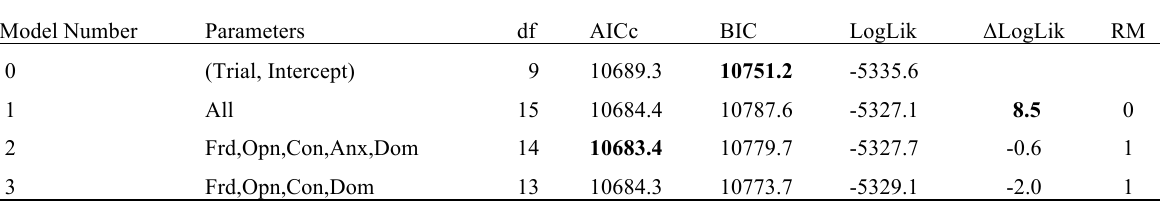
Model Selection Results for Regressions Predicting Log Transformed